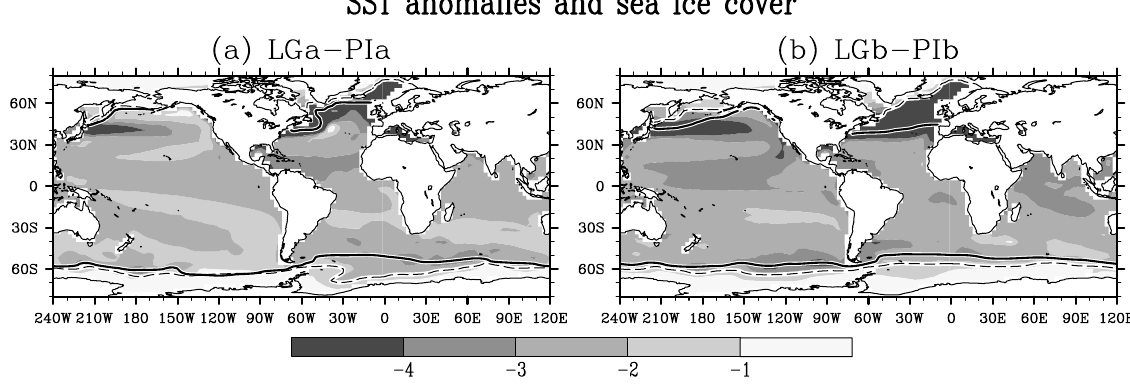
Fig. 3. SST anomaly ( ◦ C) (a) between LGa and PIa and (b) between LGb and PIb. Solid (dashed) lines show glacial (preindustrial) annual-mean sea ice fraction of 0.1.